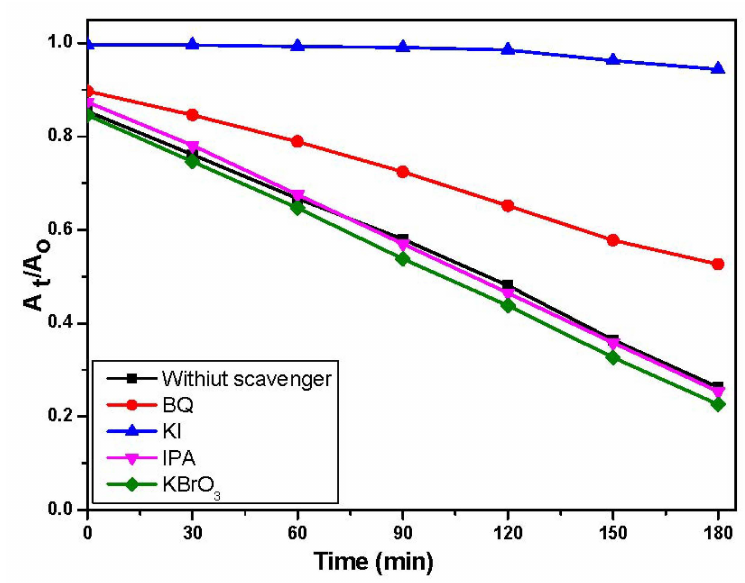
Figure 12. Scavengers’ effects on TL oxidation efficiency using the TC10 composite under UV irradiation.